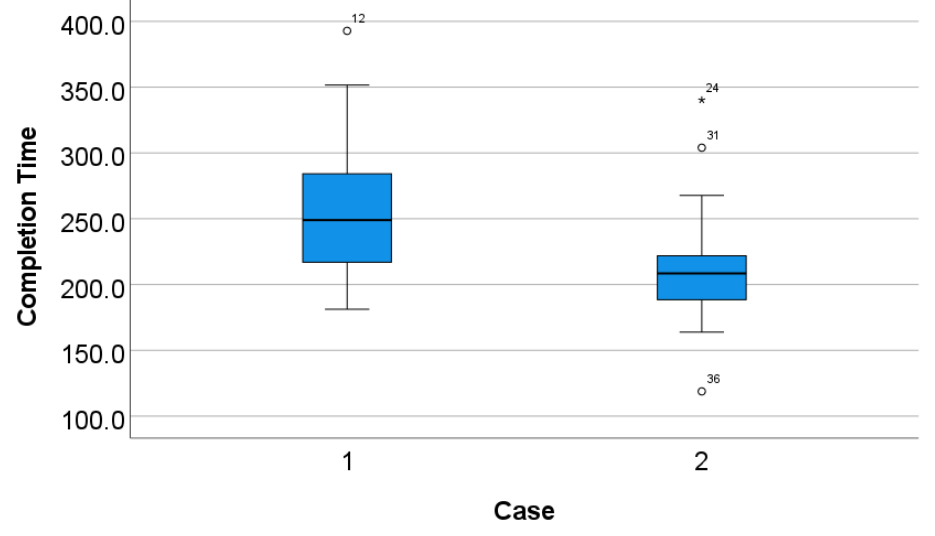
Figure 8. Decrease in completion time owing to use of the hybrid controller (Case 1: Position control and Case 2: Hybrid